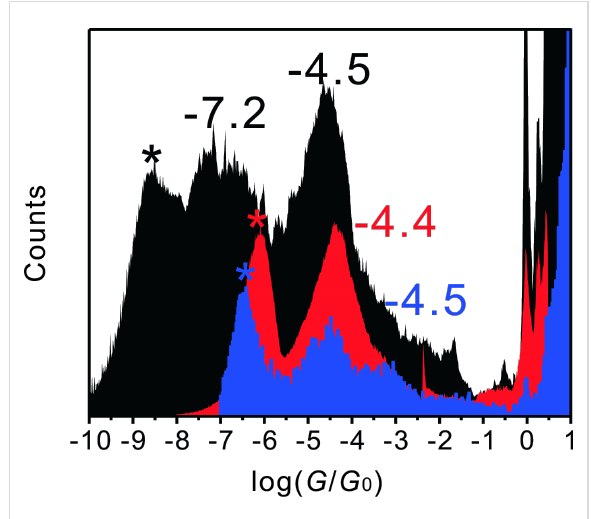
Figure 7: Conductance histograms of 0.1 mM AC in THF/decane (v:v = 1:4). Black: From 500 current–distance stretching curves in a MCBJ setup. Red: From 2000 current–distance stretching curves recorded in an STM-BJ experiment, with 0.10 V bias voltage. Blue: Based on 60,000 individual I–V traces measured simultaneously in the range of − 0.40 to 0.40 V, in the molecular junction region of the above MCBJ